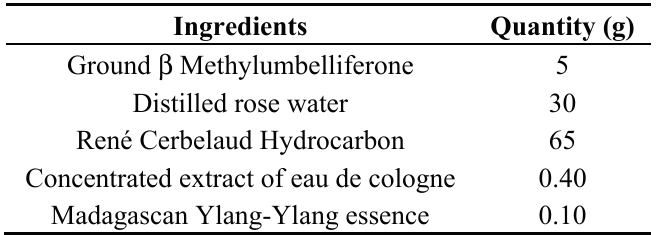
Table 2. Cream presented as “not letting ultraviolet rays